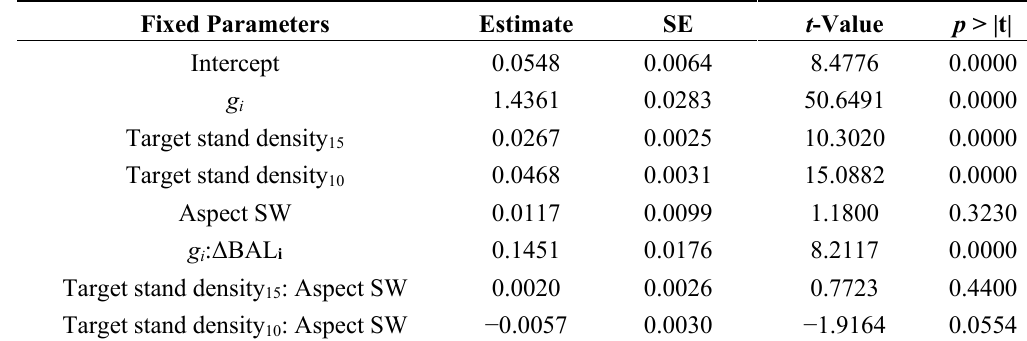
Table 6. Model output of the individual tree level model for basal area